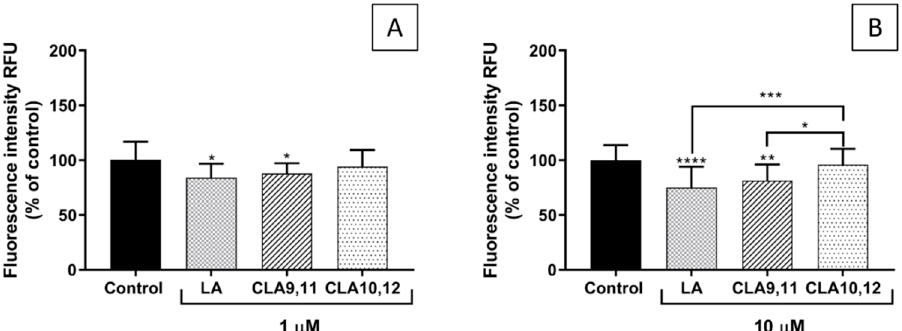
Figure 5. Adhesion of THP-1 cells (% of control) to EA.hy926 cells incubated for 48 h with DMEM containing 0.1% of ethanol (Control) or different concentrations (1 μ M ( A ), 10 μ M ( B )) of fatty acid, followed by incubation with tumour necrosis factor α (1 ng/mL) for 24 h and then 1 h co-incubation with THP-1 cells. Bars are mean ± SD of 9 samples from 3 experiments. Data were analysed using one-way ANOVA with Tukey post hoc test. * p < 0.05; ** p < 0.01; *** p <0.001; **** p < 0.0001; where asterisks are shown immediately above a bar they refer to dfference from Control and where asterisks are shown above a horizontal line they refer to differences between the two groups indicated by that line. LA, linoleic acid; CLA9,11, cis -9, trans -11 linoleic acid; CLA10,12, trans -10, cis -12 linoleic acid. Images taken under the fluorescence microscope agree with the quantitative results, showing a lower number of THP-1 monocytes (green spots) when ECs were pre-incubated with LA and CLA9,11 (Figure 6B,C).